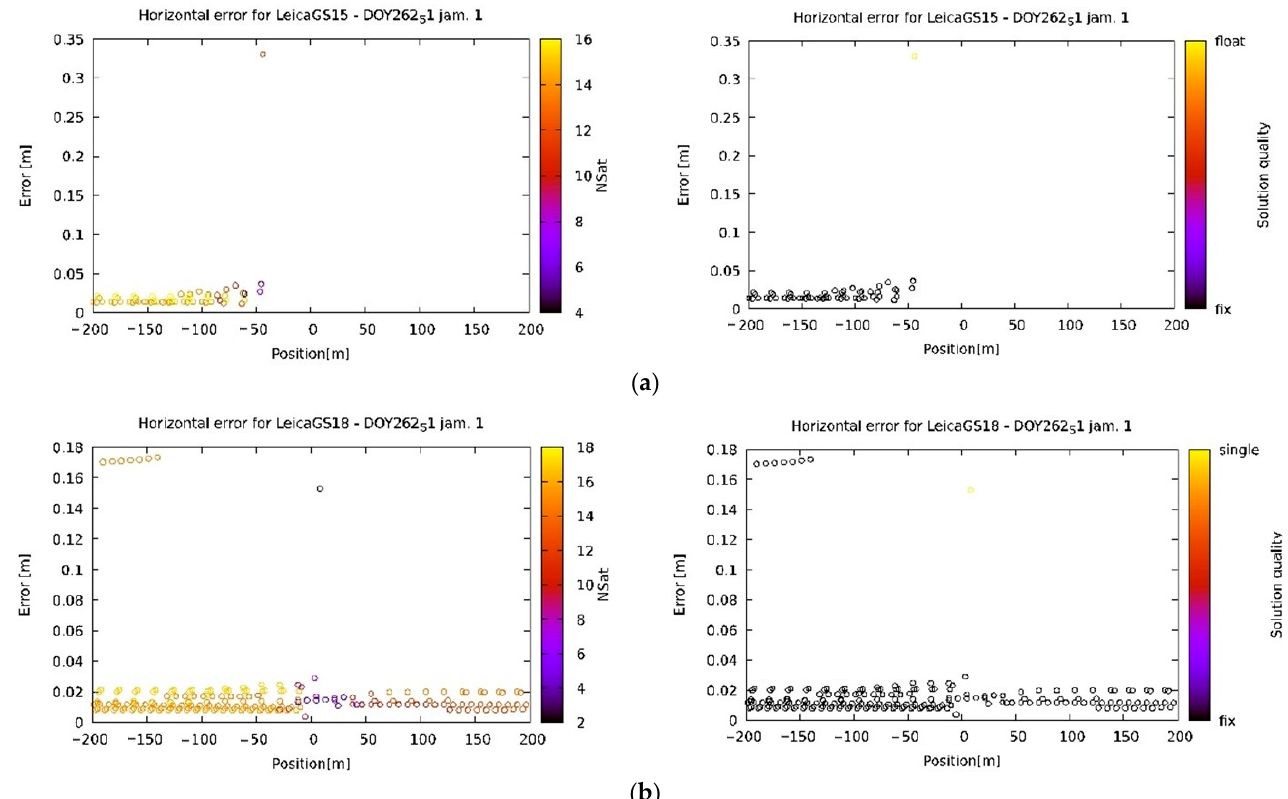
Figure 13. Horizontal accuracy for geodetic devices. After the arrival of the jammer in the vicinity of the receiver they either stop reporting their position (case ( a )—Leica GS15) or use a smaller number of satellites for the determination (case ( b )—Leica GS18).